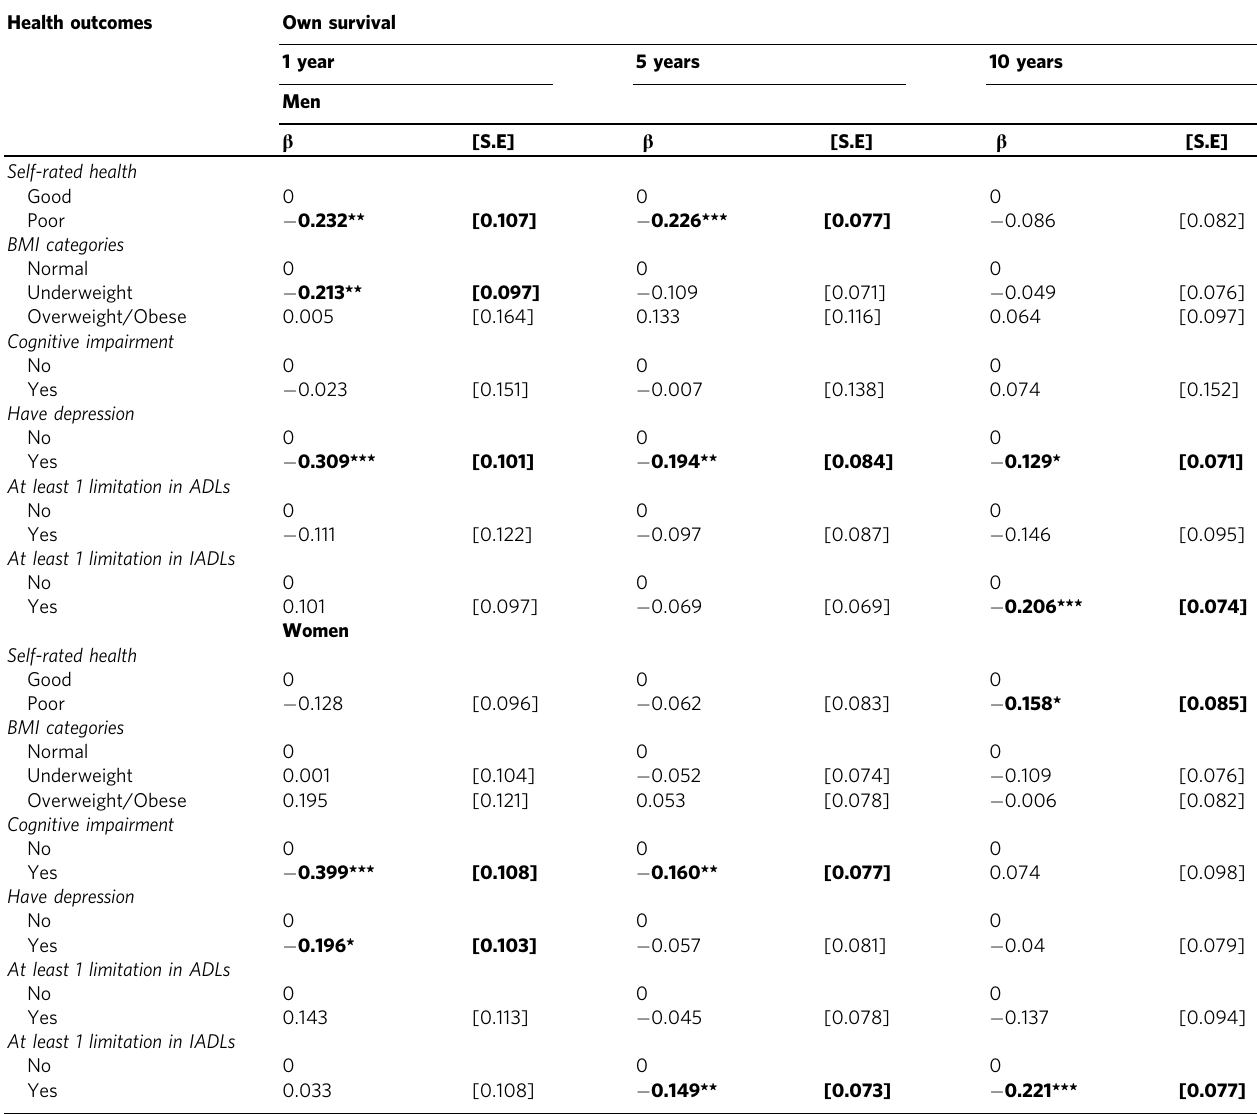
Table 3 Generalized linear regression models for subjective probability of own survival according to various health outcomes, by gender, LASI, 2017 –